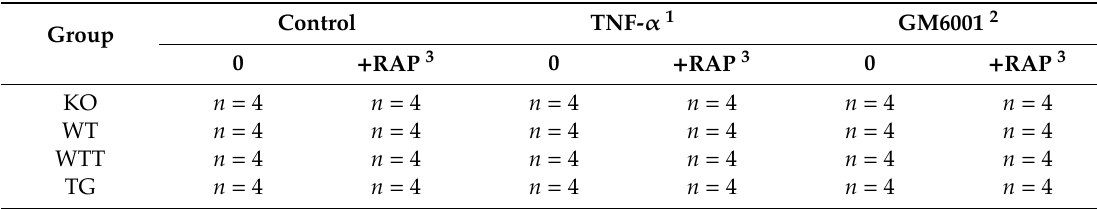
Table 3. Experimental setting for the RAP (receptor-associated protein)